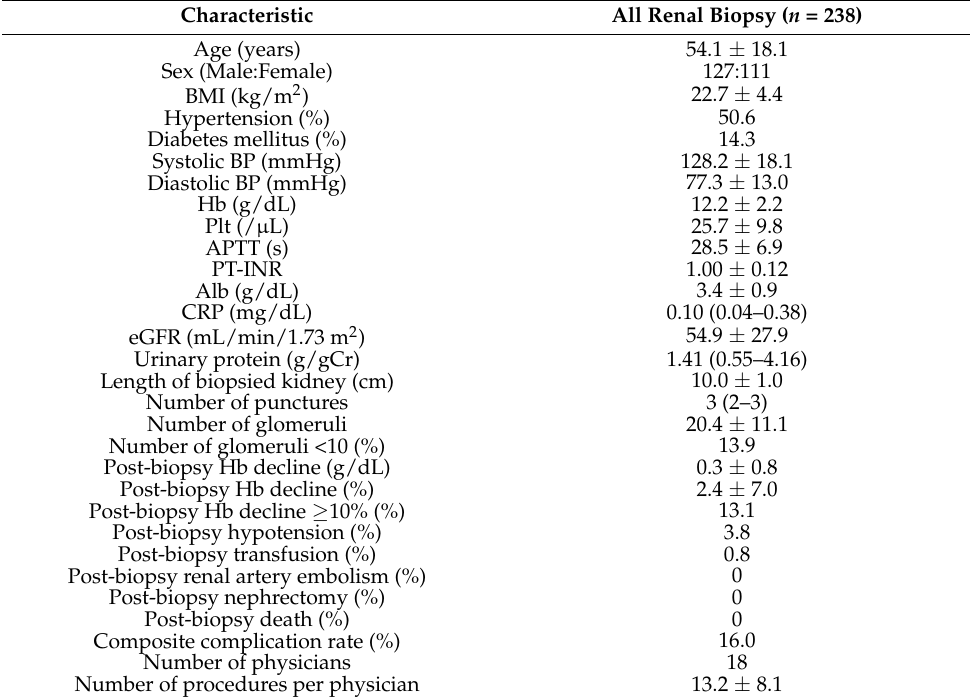
Table 1. Patient characteristics.